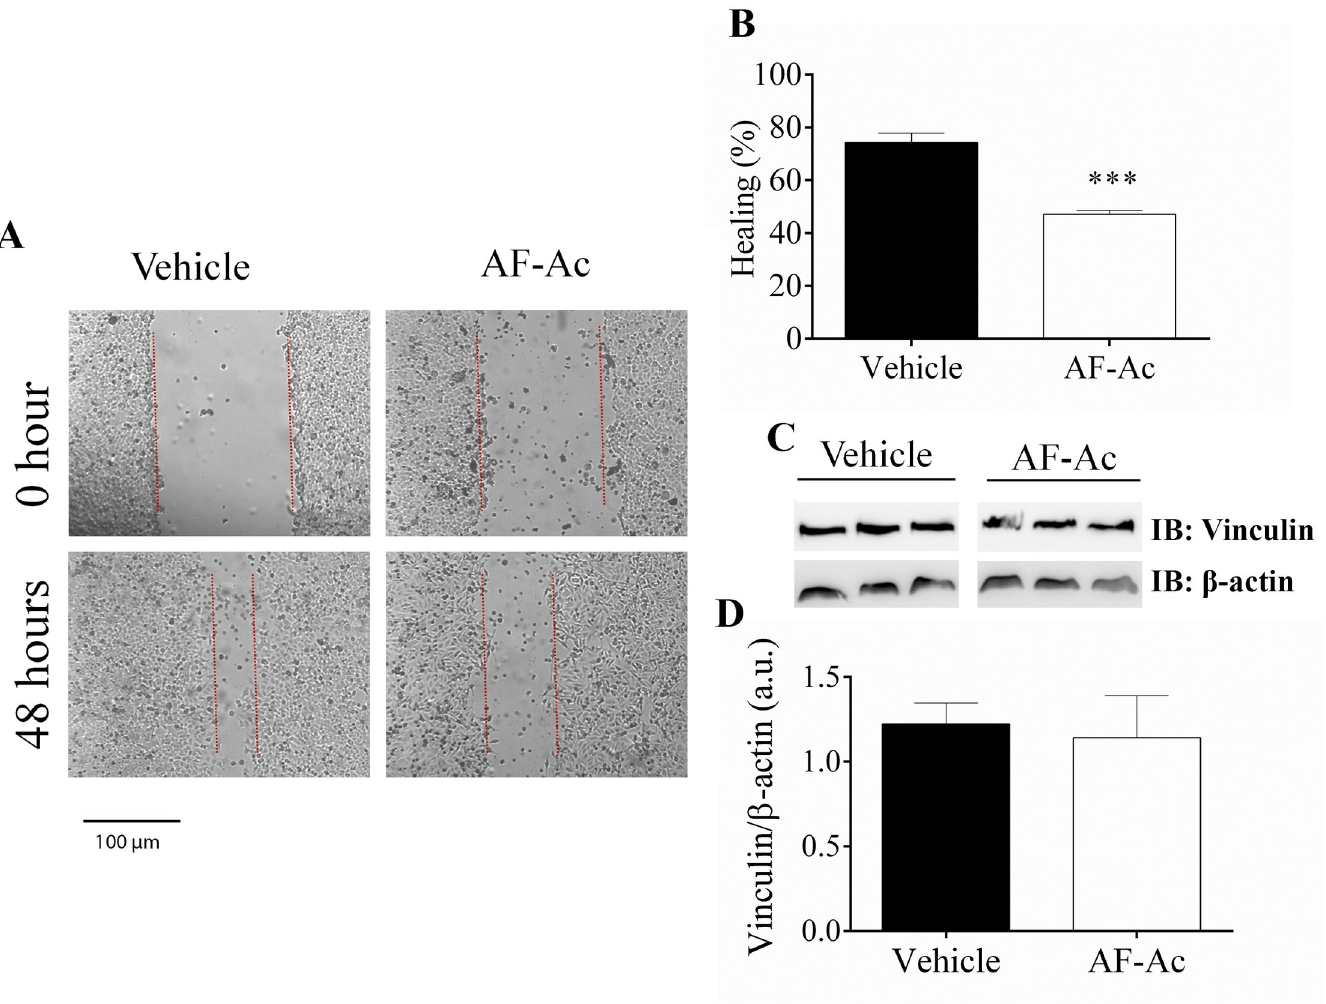
Fig 6. Representative image of in vitro wound healing assay performed with HepG2 cells. Images were selected from a representative well 48 h after stimulation with 50 μ g/mL AF-Ac or vehicle (control, cells treated with DMEM medium containing 0.05% DMSO). Scale bar = 100 μ m (A). Average of wound healing closure 48 h after stimulation with AF-Ac (n = 5 wells/group, for each time point). Results represent % of initial wound area (0 h) (B). Representative cropped immunoblotting of total HepG2 cell lysates probed with anti-vinculin and anti- β -actin, used as protein loading control (C). Immunoblotting densitometry analysis. Results show β -actin normalized proteins expression (n = 3 individual experiments/group) (D). Values are expressed as mean ± SD. Significance levels are indicated by ��� p < 0.001 (unpaired t-test) when compared to the vehicle group. Each protein was analyzed in cropped membranes of different Western blots along with other proteins. Full- length blots are presented in S1 Raw